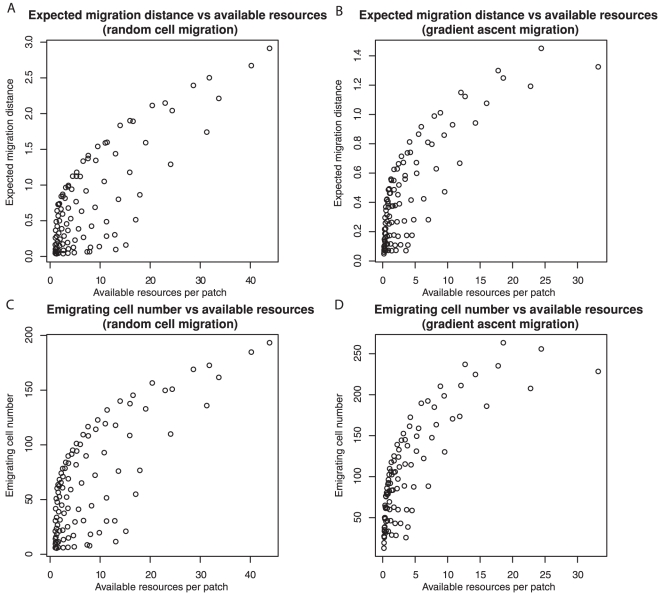
Available resources, those not currently being fully exploited by the cell population, select for increased cell migration.The expected migration distance that evolved (A, B) was closely correlated with the average amount of transiently unutilized, available resources per patch. Similarly, the number of cells emigrating from the neoplasm was also highly correlated with amount of available resources (C, D). This was true, regardless of whether cell migration was random (A, C) or by gradient ascent (B, D).